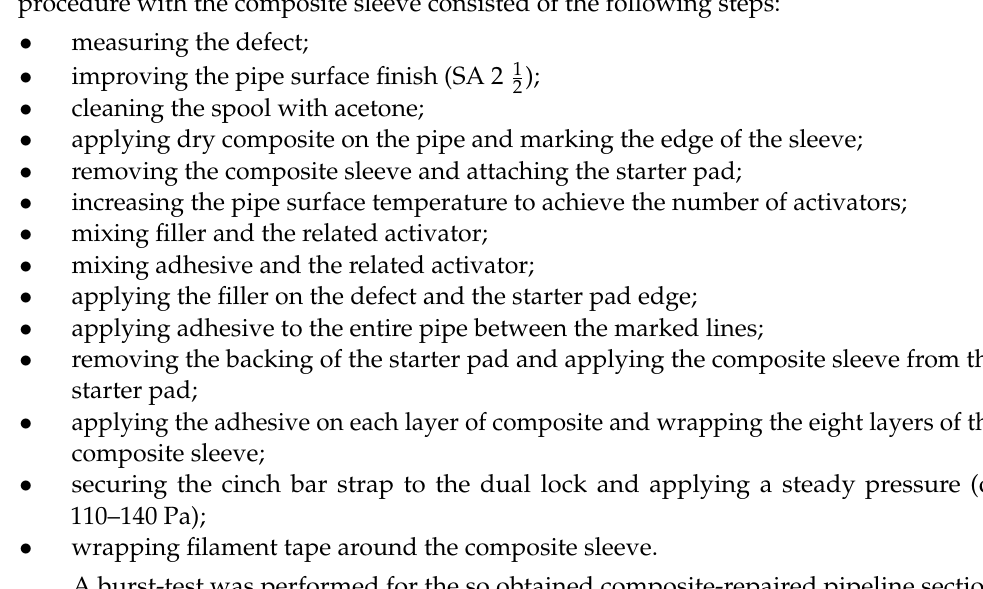
Figure 2. Flow of operations to produce the test article: ( a ) API 5L X60 steel pipeline, ( b ) cut and closed with lateral caps to obtain a tank; ( c ) machined defect and corresponding ( d , e ) repairing process through the composite sleeve.